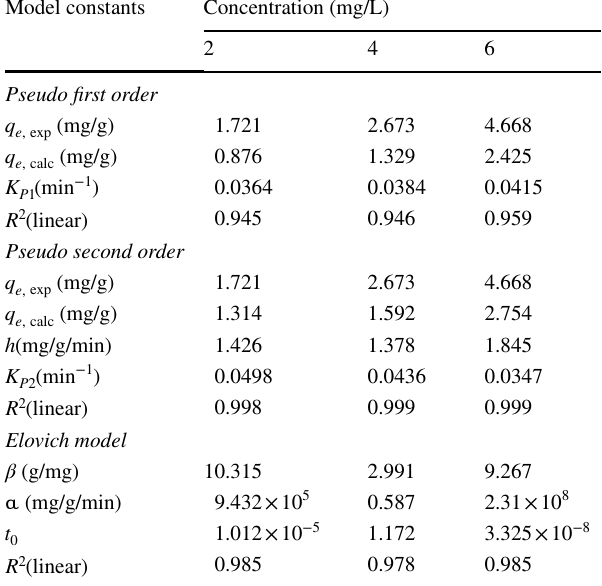
Table 2 Kinetic constants for studied models